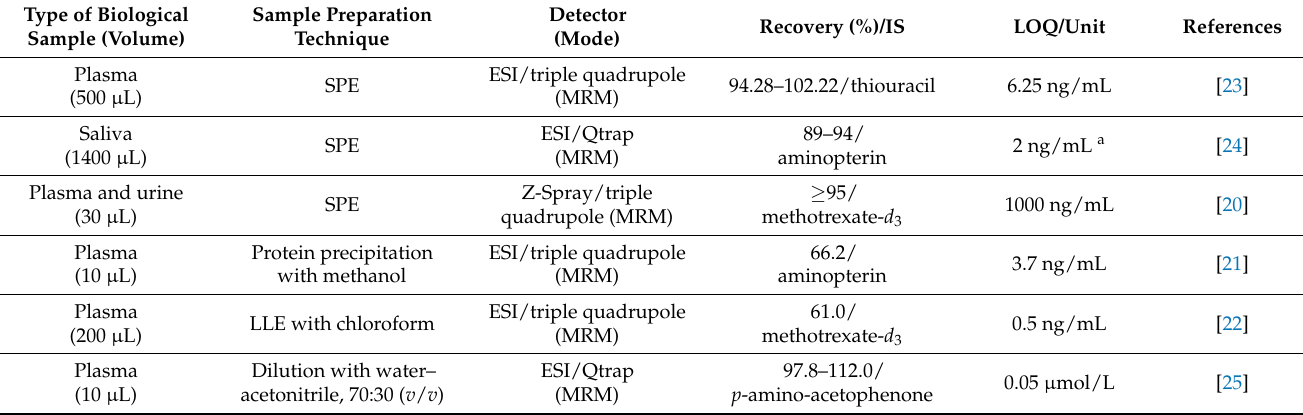
Table 3. Comparison of LC-MS methods for determination of methotrexate in biological